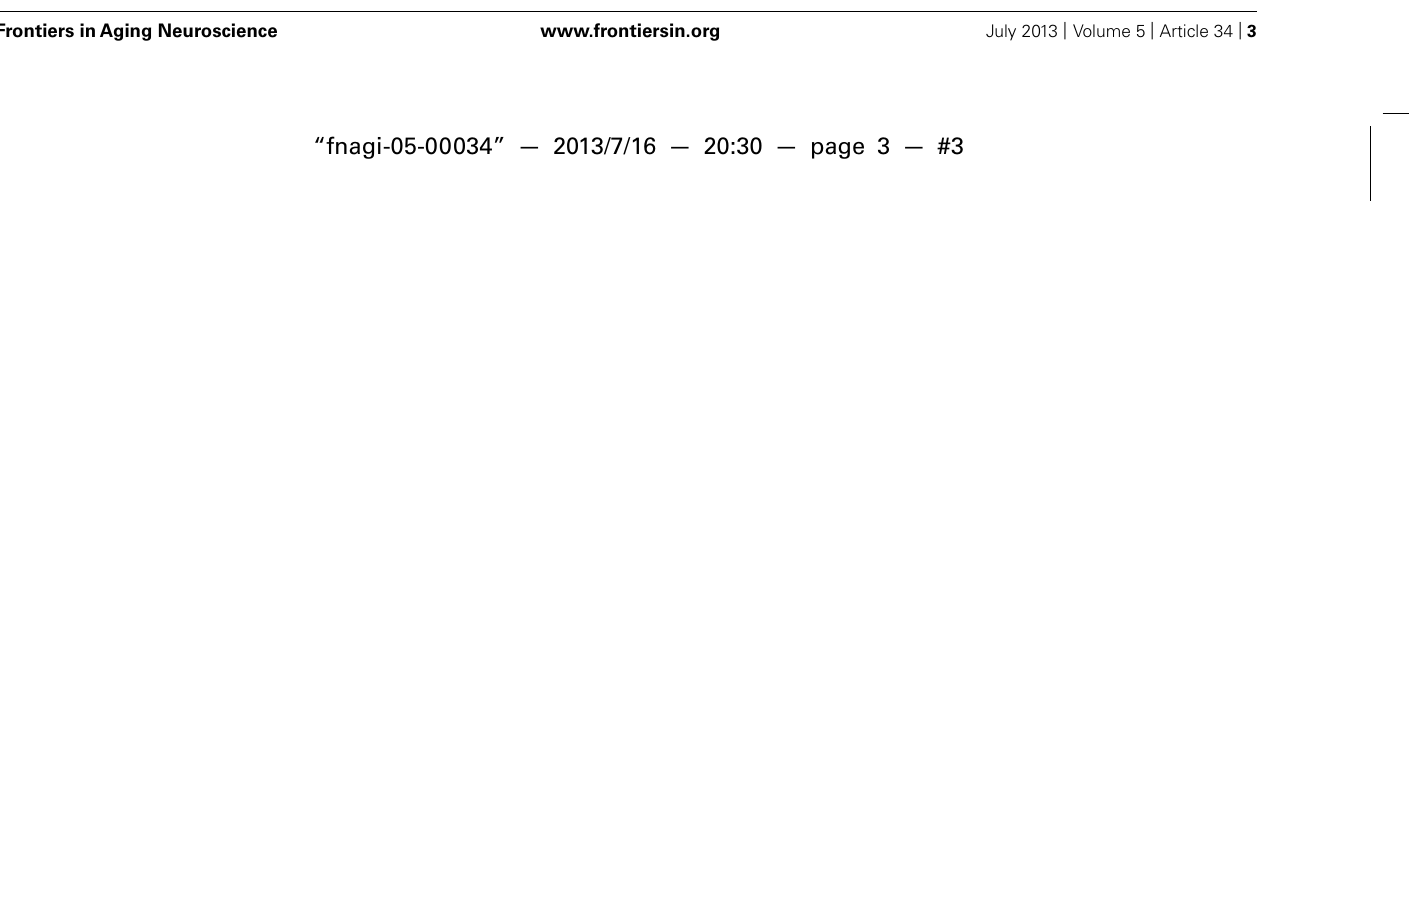
FIGURE 1 | Neuronal iron uptake and export. Iron is imported into the cell either as low molecular weight complexes with citrate/ATP, or via transferrin receptor (TfR1)-mediated endocytosis (1). Export of iron from the endosome via divalent metal transporter-1 (DMT-1) directly contributes to the labile iron pool (2), which constitutes the available iron content of the neuron and is